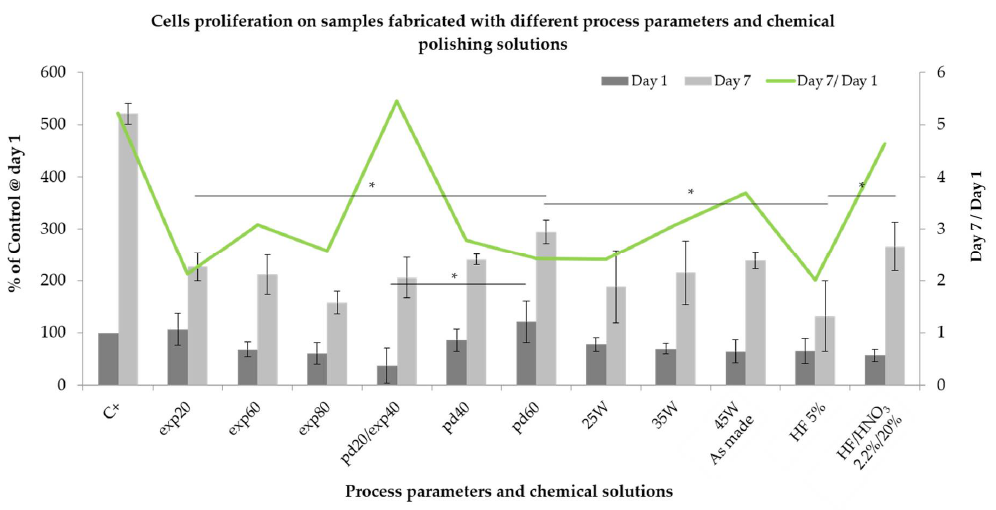
Figure 6. Cells proliferation after 1 and 7 day of incubation measured by means of MTS assay. Sample encoded pd20 represent also samples exp40. Samples encoded 45 W were used for chemical polishing, therefore they represent “as-made”. *—Significant difference between indicated groups (* p < 0.05).